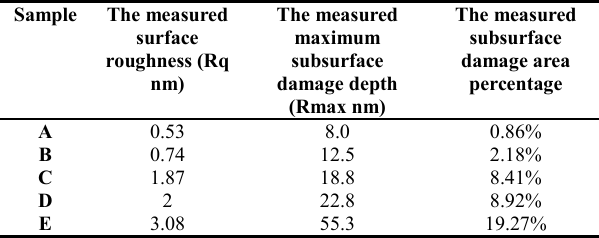
Fig. 1. The AFM images of (a) sample A, (b) sample B, (c) sample C, (d) sample D and (e) sample E with same color scale. Table 1. The measured subsurface damage